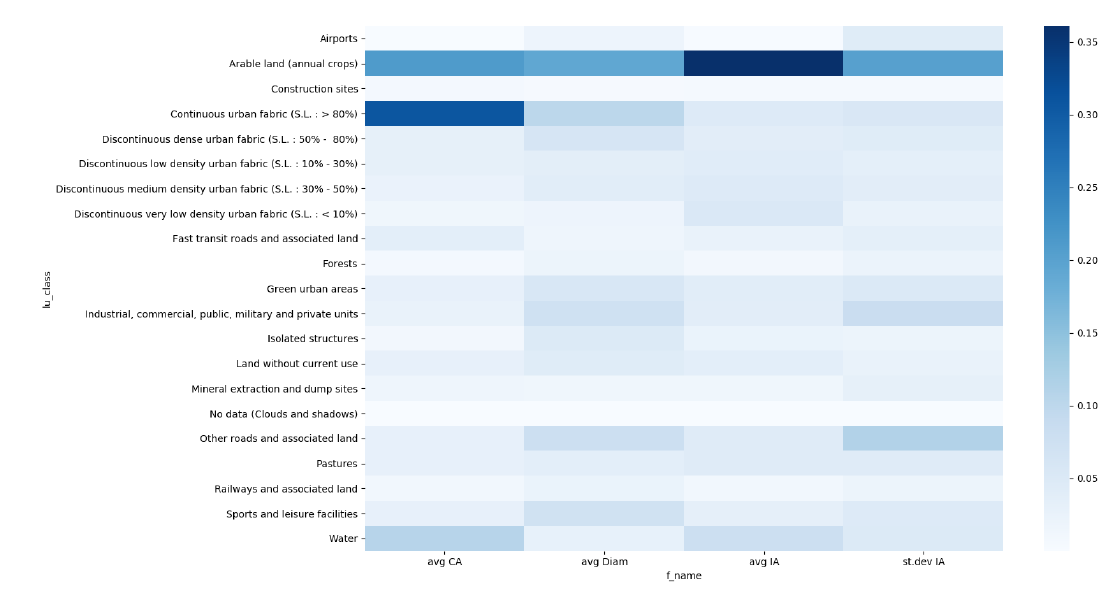
Figure 9. Importance of land use classes for predicting community